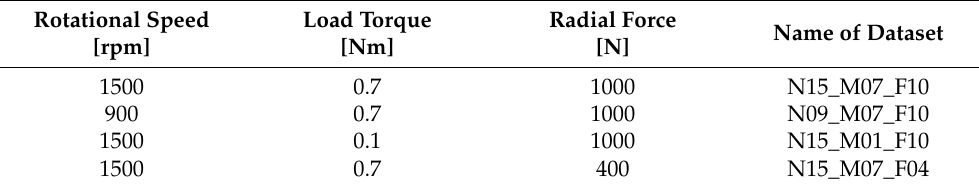
Table 2. Parameter setting of the experimental dataset.